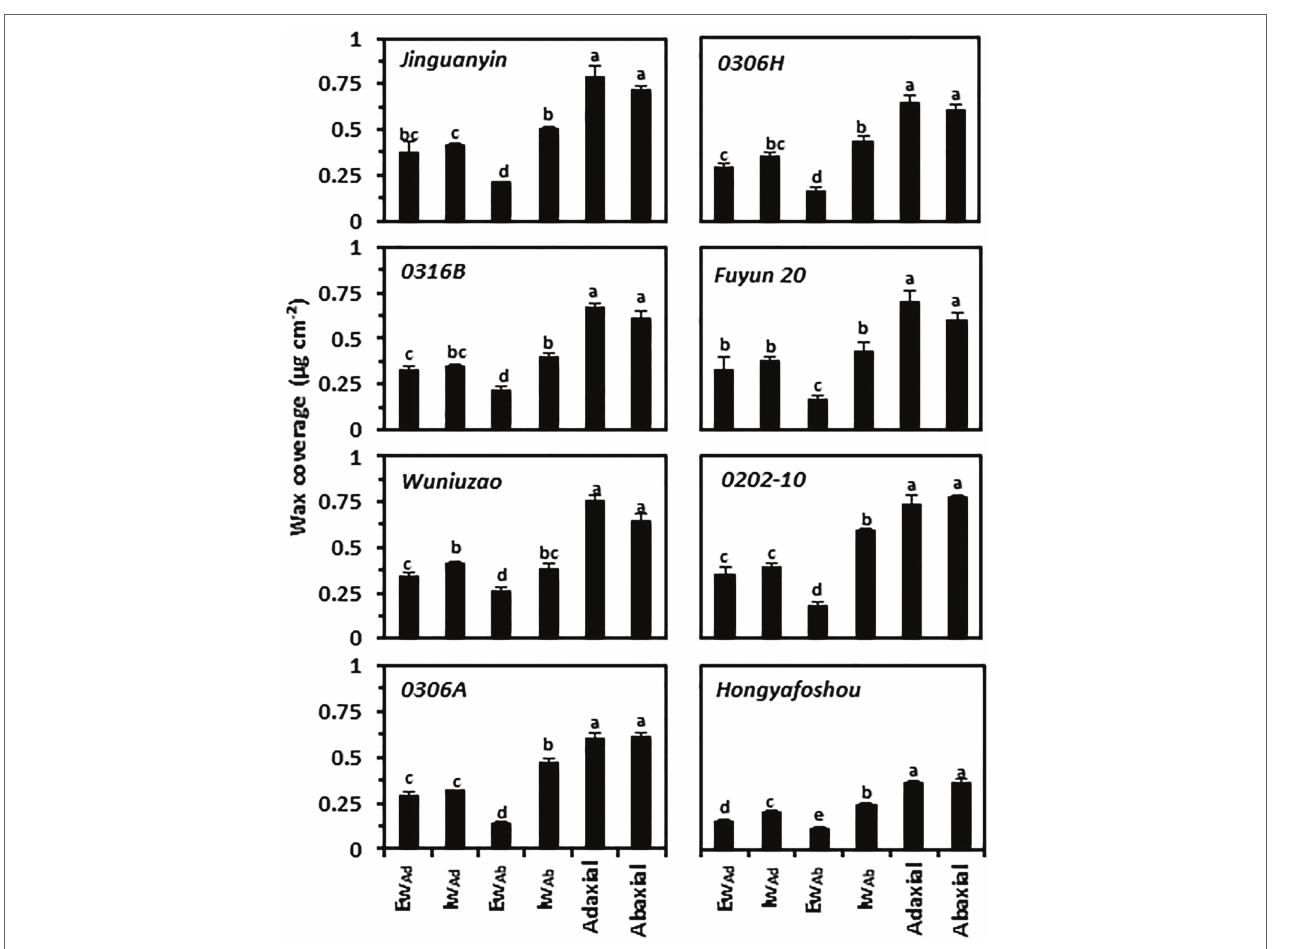
FIGURE 2 | Cuticular wax coverage from the epi- and the intracuticular compartments of both leaf surfaces. Ew: the epicuticular waxes; Iw: the intracuticular waxes; Ad: the adaxial surface; Ab: the abaxial surface. Different lowercase letters represent the statistical significance ( p <